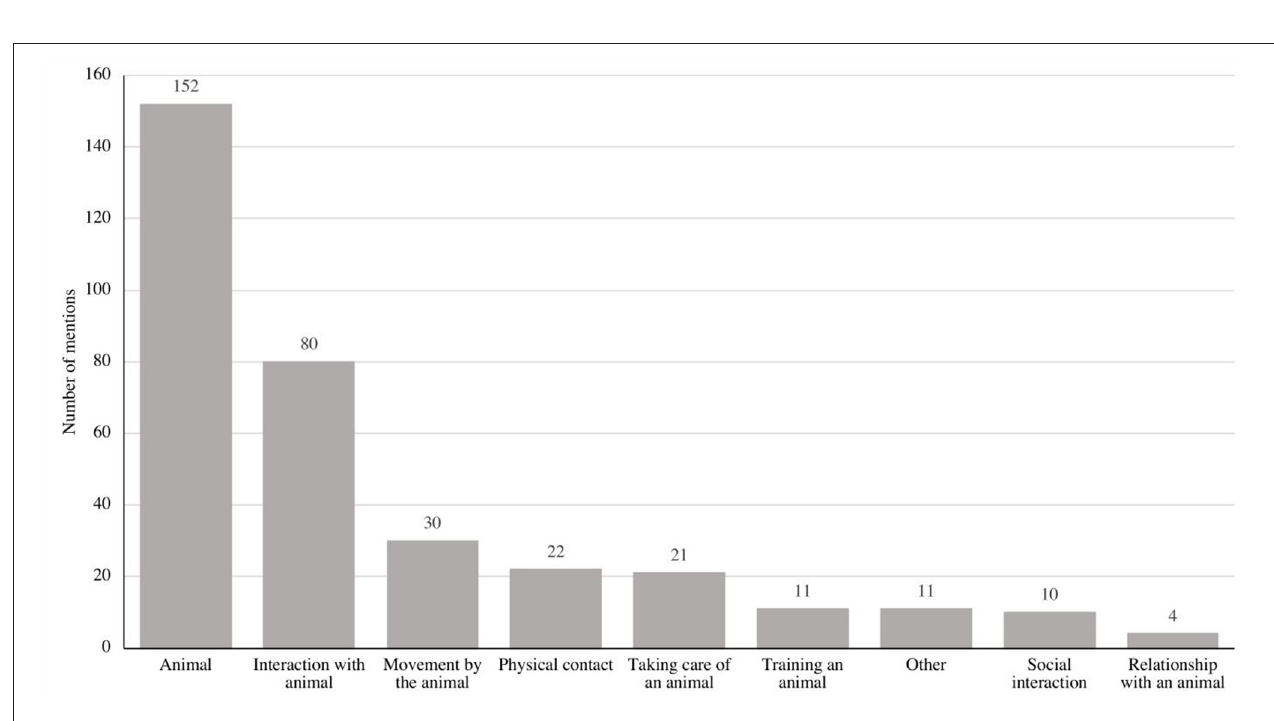
FIGURE 3 | Number of identified specific